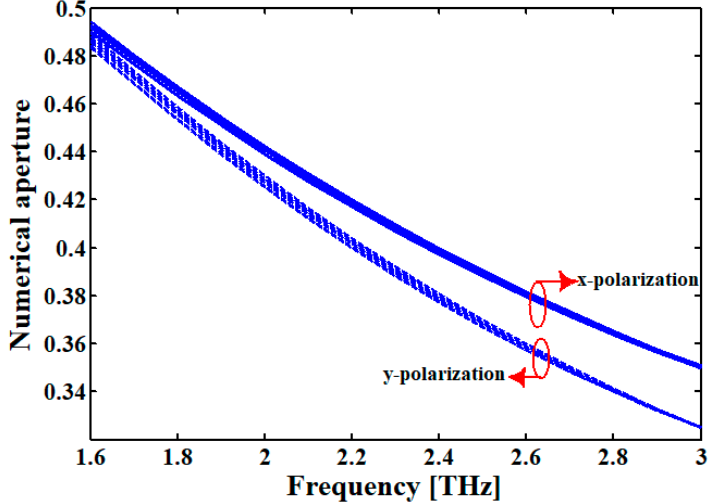
Figure 15. Numerical aperture of the proposed hollow-core sensor as a function of frequency at L = 280 µm.